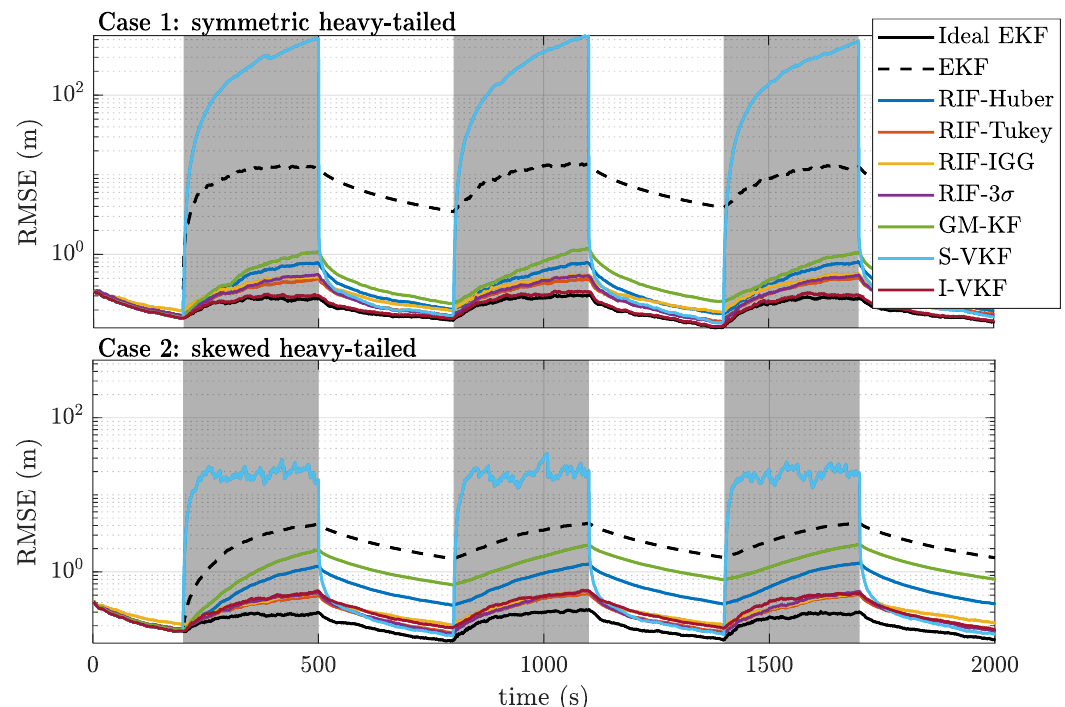
Figure 5. Root mean squared error (RMSE) for the float positioning results over time for cases 1 ( top ) and 2 ( bottom